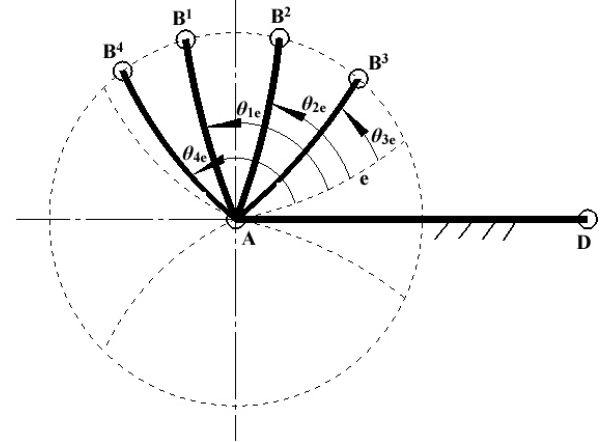
Figure 6. Order defect discrimination.